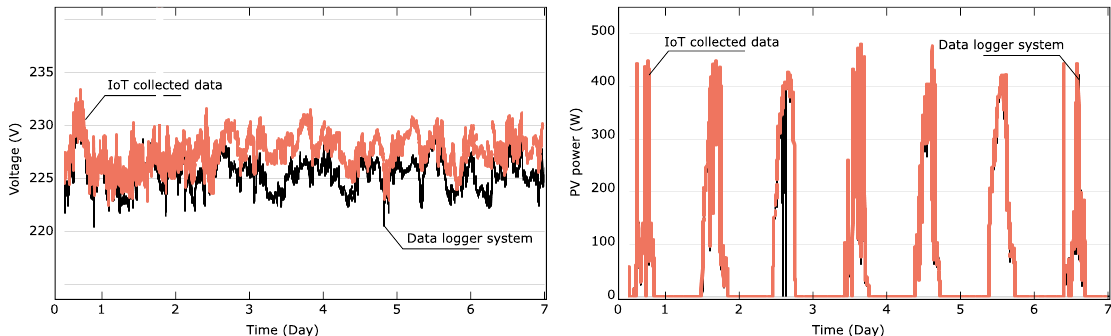
Figure 10. PV-generated power comparison: low-cost proposed system vs. data-logger